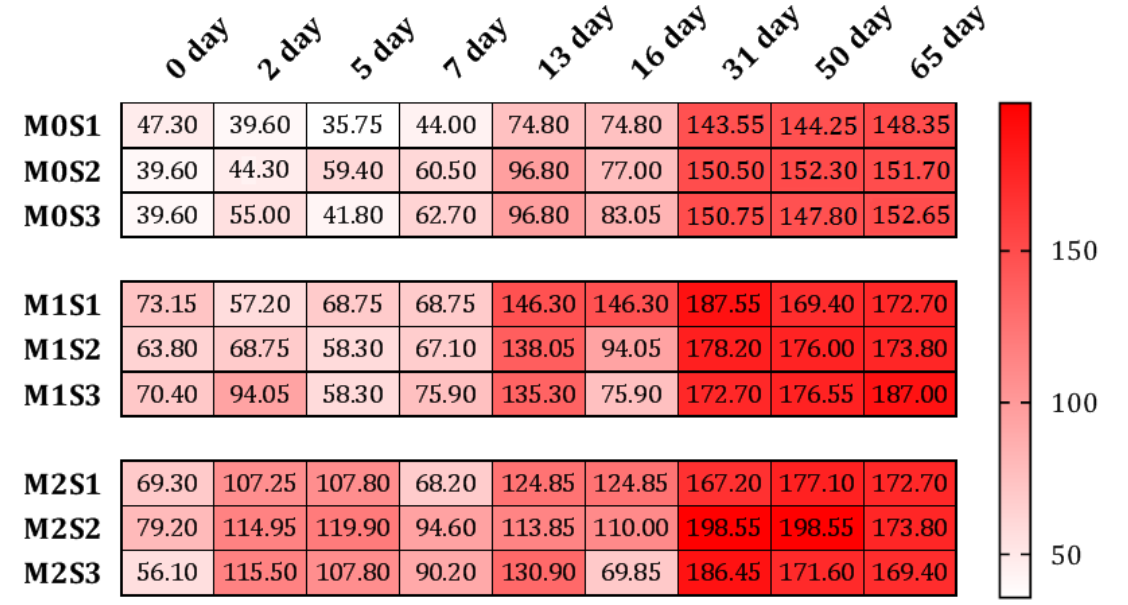
Figure 1. CO 2 emissions i n calcareous saline soil under different organic material a nd water availability inputs throug h 65 days of